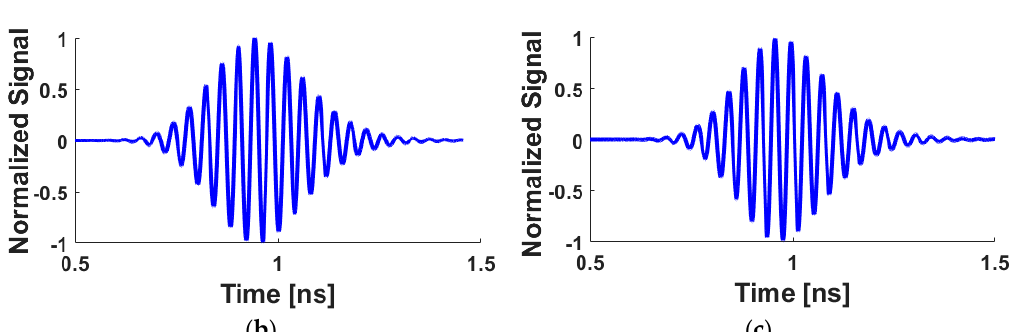
Figure 7. ( a ) Transmitted signal in free space and received pulses for ( b ) side by side and ( c ) face to face.